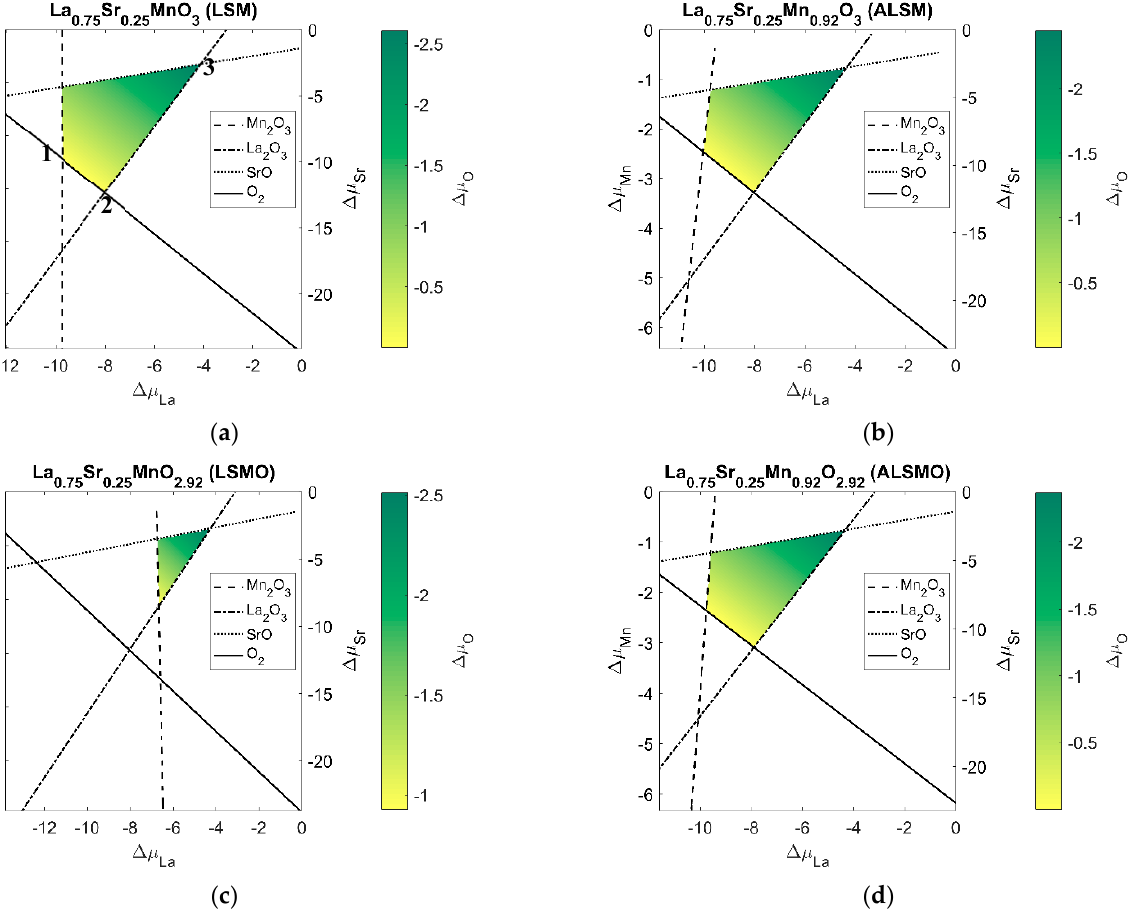
Figure 3. Phase plots for equilibrium growth for ( a ) La 0.75 Sr 0.25 MnO 3 (LSM), ( b ) ALSM, ( c ) LSMO, and ( d ) ALSMO (001) surfaces. The shaded region indicates the region of atomic chemical potentials where intermediate oxides do not form. The color corresponds to the chemical potential of oxygen.